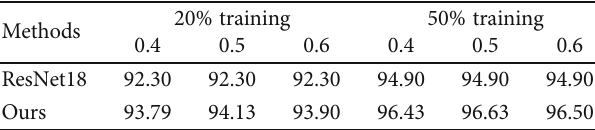
Table 2: Comparison of overall accuracy (%) with di ff erent T on the RSSCN7 data set.